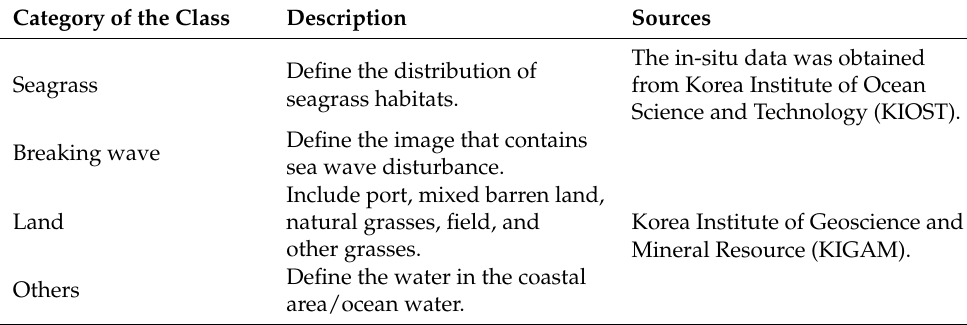
Table 1. Classes used in this study for classification.